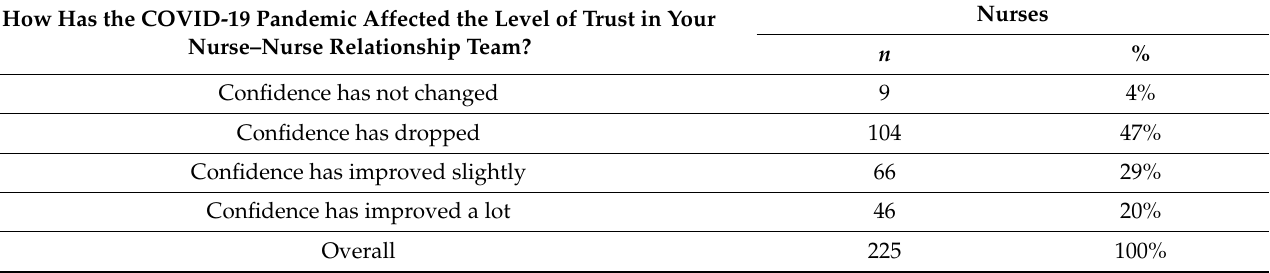
Table 4. Characteristics of the assessment of the level of trust in the team in the nurse–nurse relationship in the group of respondents.